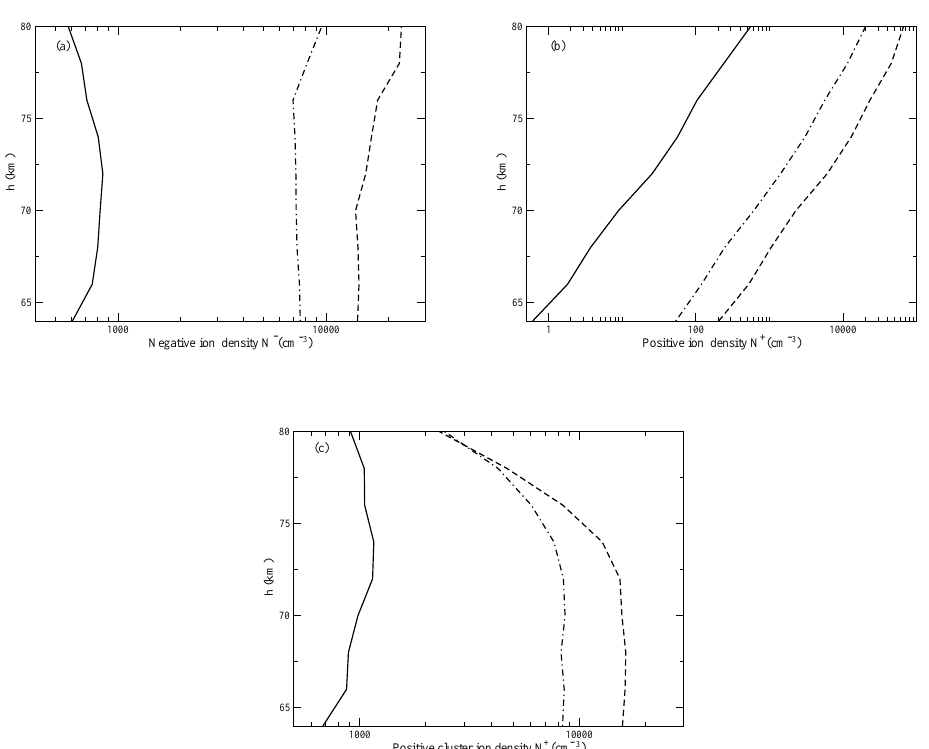
Fig. 8. Altitude profiles of three types of ion densities as obtained from the GPI scheme: (a) negative ions, (b) positive ions, and (c) positive cluster ions. The solid, dashed and dot-dashed lines represent respectively the ambient profile, the profile at the peak and the profile at a time during recovery of the X-type flares as discussed in the text.